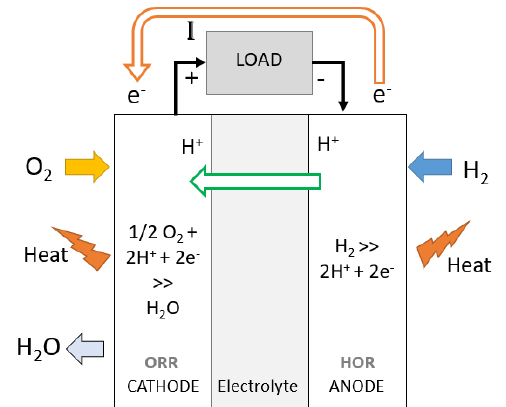
Figure 11. Proton exchange membrane fuel cell hydrogen oxidation and oxygen reduction reactions (HOR and ORR) at anode and cathode generating electropotential across the external electrical load.